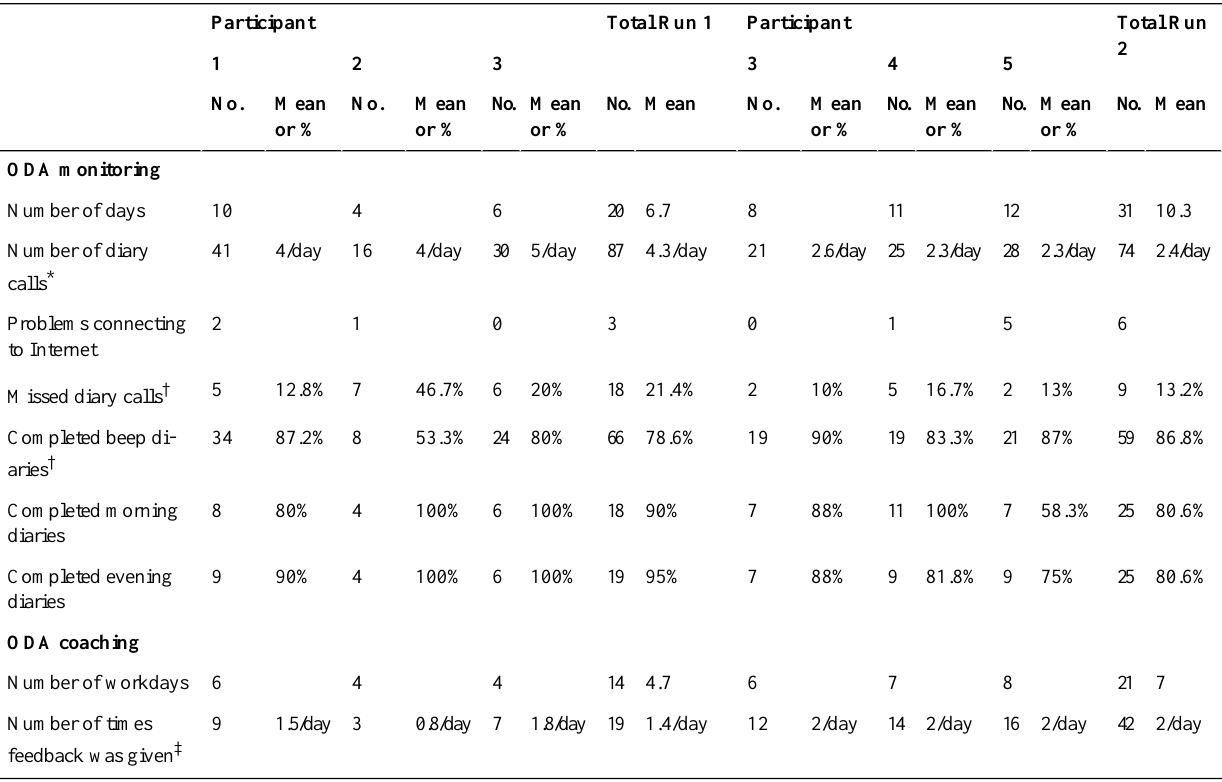
Total Run 2ParticipantTotal Run 1Participant